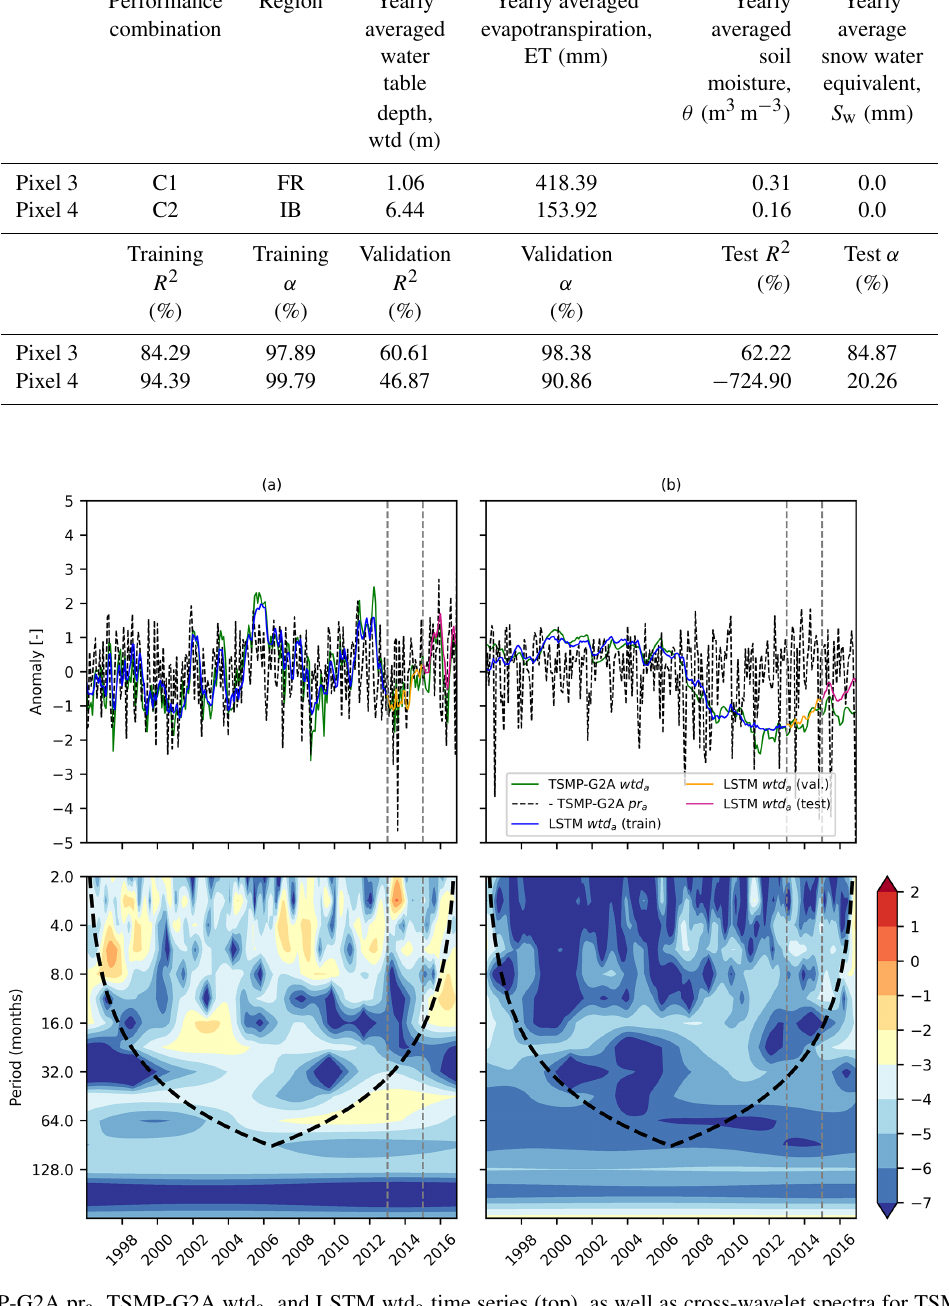
Figure C1. TSMP-G2A pr a , TSMP-G2A wtd a , and LSTM wtd a time series (top), as well as cross-wavelet spectra for TSMP-G2A pr a and wtd a series (bottom), at (a) pixel 3 and (b) pixel 4. The lines have the same definitions as in Fig.